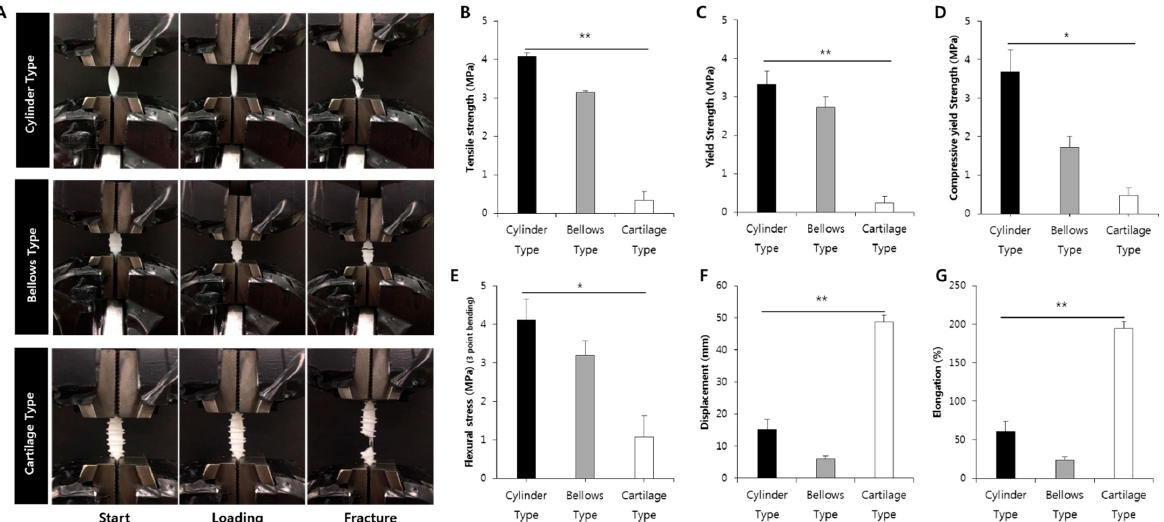
Figure 10. Results of mechanical properties measurements. ( A ) Tensile test process of each scaffold, ( B ) tensile strengths of three types of trachea scaffolds, ( C ) yield strengths of three types of trachea scaffolds, ( D ) compressive yield strengths of three types of trachea scaffolds, ( E ) flexural stress of three types of trachea scaffolds by 3 point bending test, ( F ) displacements of three types of trachea scaffolds, and ( G ) elongations of three types of trachea scaffolds. (* p < 0.05, ** p < 0.001).